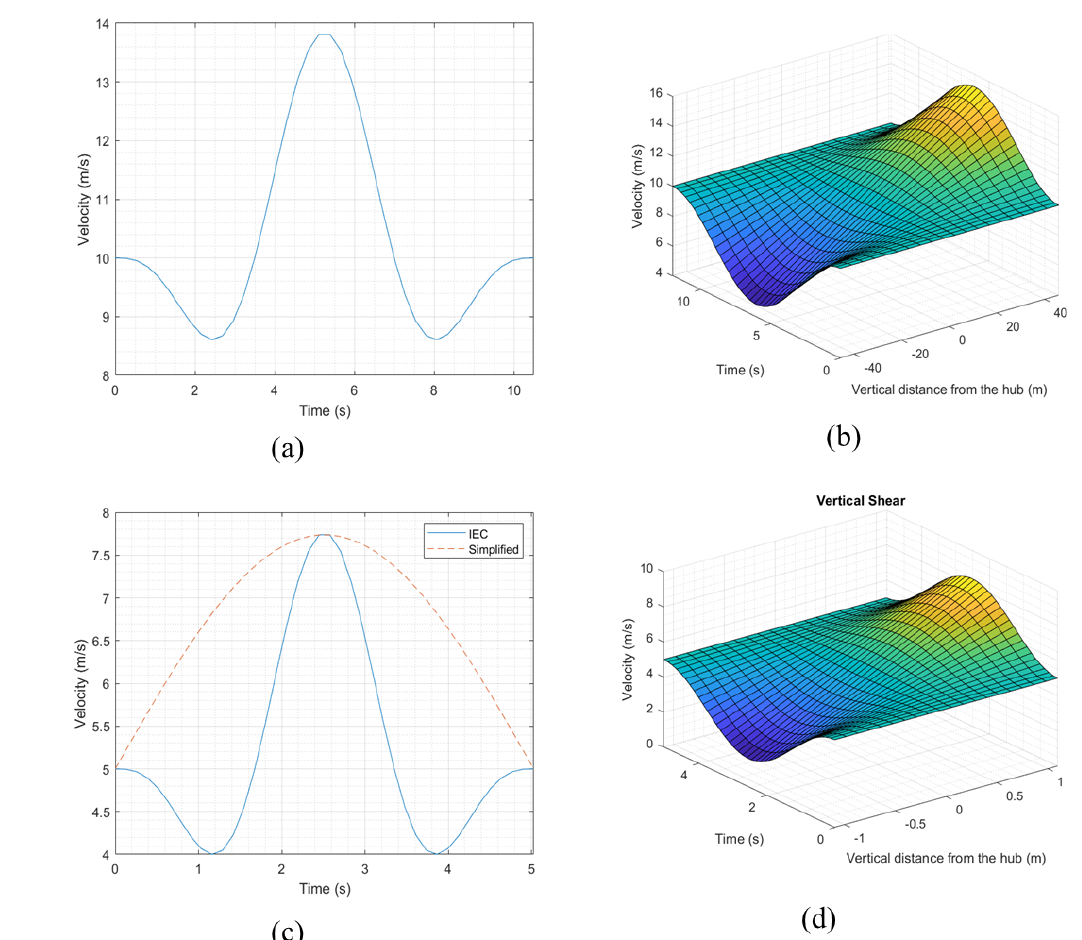
Figure 8. The extreme operational conditions for a full-scale HAWT class B-III with 92m diameter and hub height of 80m at 10m/s uniform wind speed compared with the scaled conditions for a B-III turbine with 2.2m diameter and 2m hub height at 5m/s average wind speed. (a) Full-scale extreme operational gust. (b) Full-scale extreme vertical shear. (c) Scaled extreme operating gust; the solid blue line is for IEC, and the simplified gust that actually was targeted is the red dashed line. (d) Scaled extreme vertical shear.